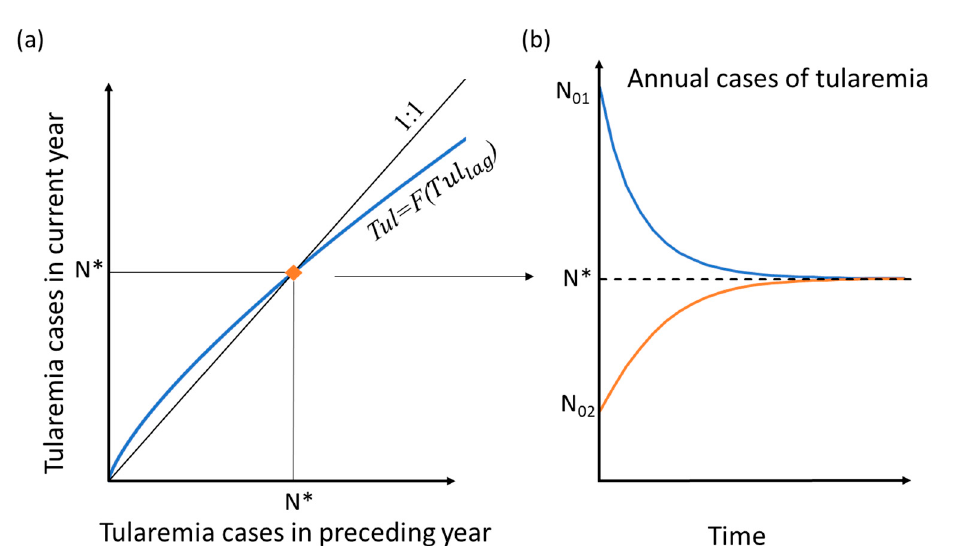
Figure 1. Conceptual diagram of resulting annual number of tularemia outbreaks under some given, unchanging hydroclimatic conditions, as a function of ( a ) corresponding number of outbreaks in the preceding year and ( b ) time. The blue curve in (a) shows the number of tularemia cases in the current year (Tul) as a function of the number of cases in the preceding year (Tul lag ); the intersection of the blue curve with the black 1:1 line at Tul = Tul lag = N* identifies the expected endemic level for the (arbitrary) considered, unchanging hydroclimatic conditions. The blue and orange curves in (b) illustrate the general convergence over time to the endemic level Tul = N* (dashed line) for any initial Tul lag value (N 01 , N 02 ) under the given unchanging hydroclimatic setting.